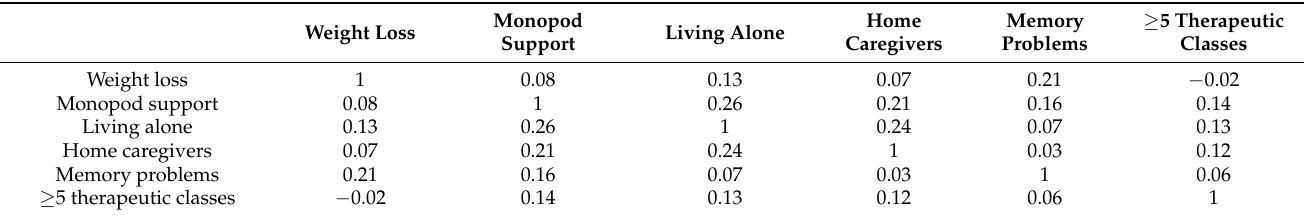
Table 9. Item correlation